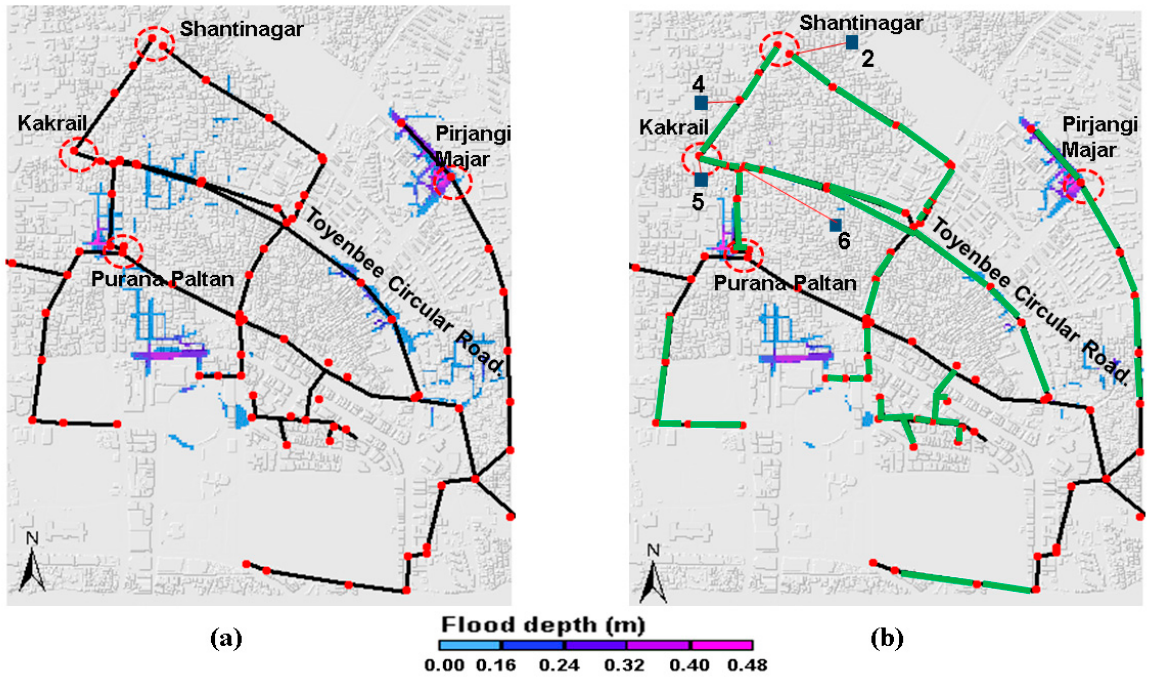
Figure 8. Flood depth maps with ( a ) the optimal green infrastructure represented in the Surf-2D model, hydraulic conductivity (ke) assigned for each grid cell, and ( b ) the optimal combination of green-grey infrastructures, pipes to be replaced (green line) and location of storage tanks (dark blue squares).